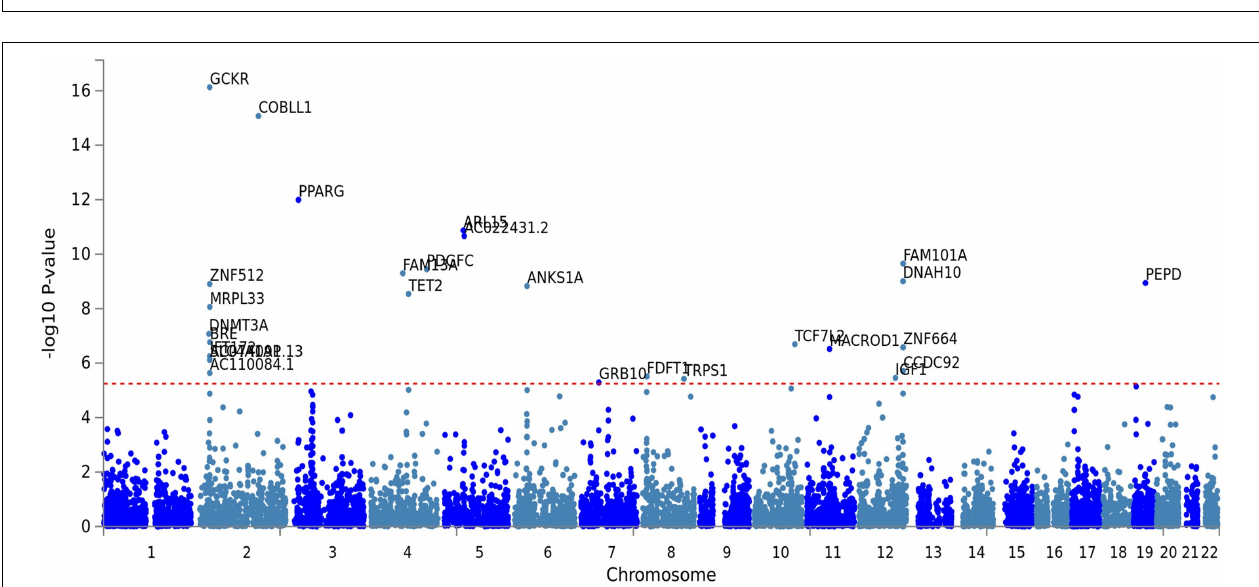
FIGURE 2 | Block scheme describing sample selection in the MAVAN cohort.